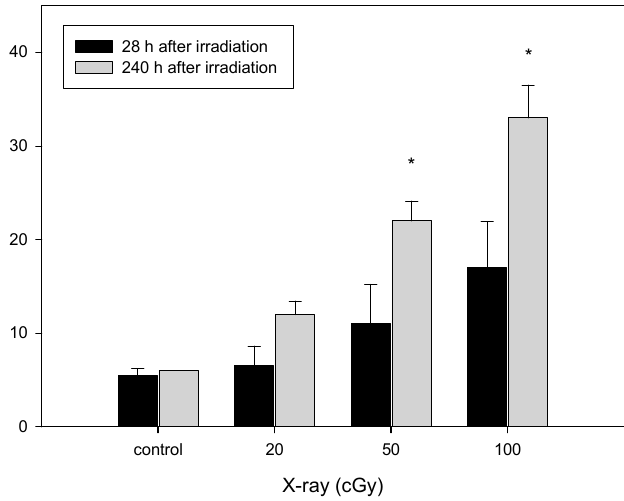
Figure 3. Total aneuploidy of chromosomes 1 and 4 in the X-irradiated fibroblasts. Data are the mean ± SD of duplicate experiments. Asterisks indicate significantly higher frequency of aneuploidy in chromosomes 1 and 4 from the cells at 240 h compared to 28 h (Mann–Whitney test, * p < 0.05).